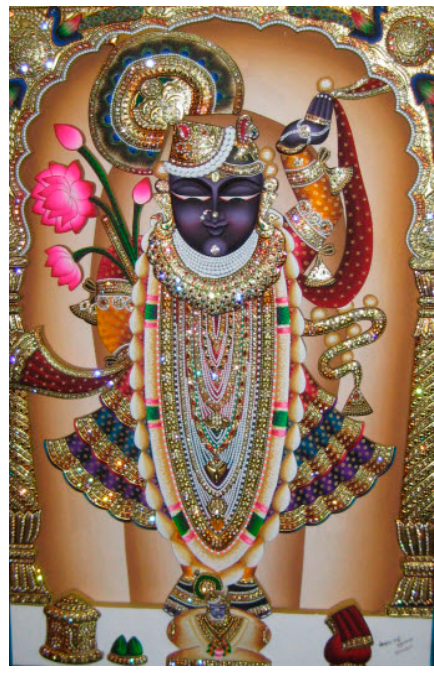
Figure 10. Shri Nathji 19 .